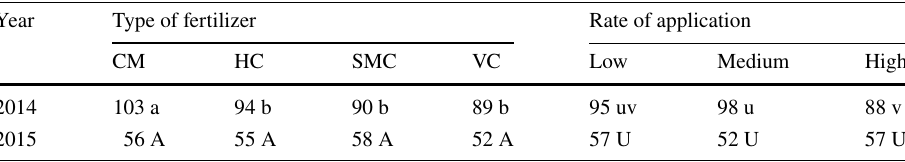
Means with *, ** and NS are significant with p ≤ 0.05, p ≤ 0.01 and not significant, Table 4 Effects of different soil amendments on yield (t ha −1 ) for both